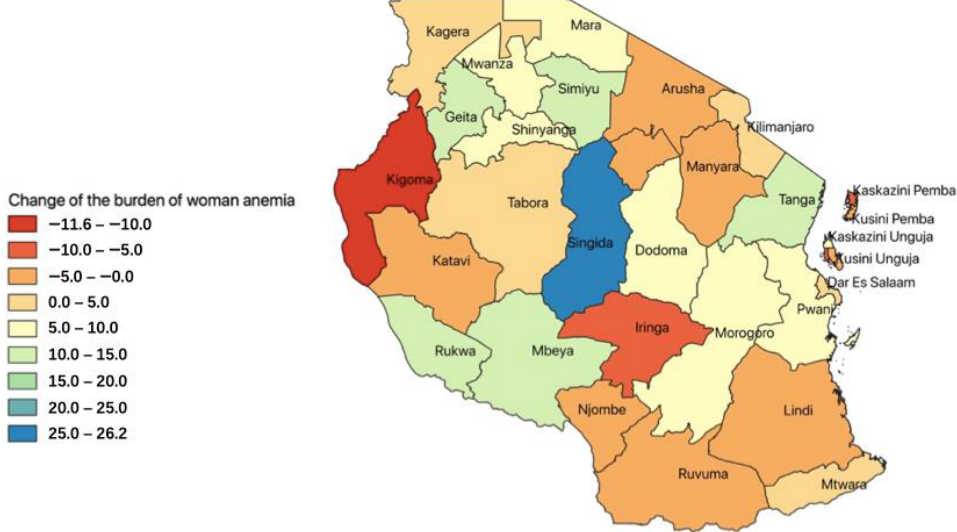
Figure 1. Geographic information system (GIS) mapping of the change in the magnitude of the burden of anemia in WRA (in percentage).